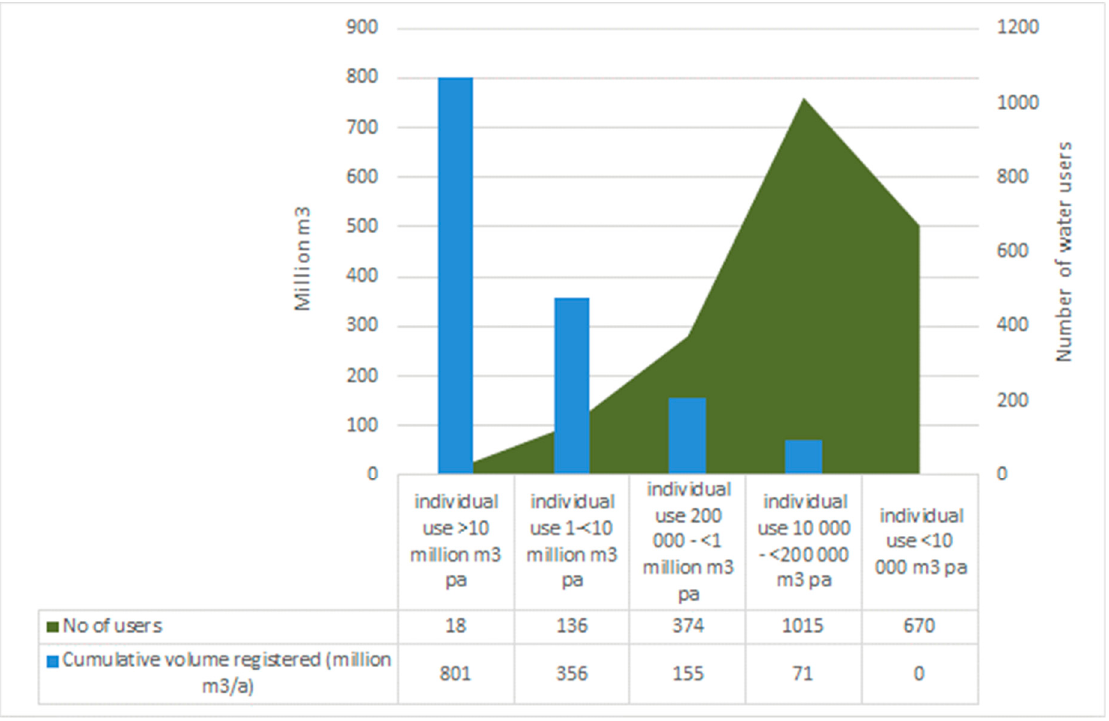
Figure 1. Number of users and volume of registered water use in the Inkomati–Usuthu Water Management Area, South Africa.